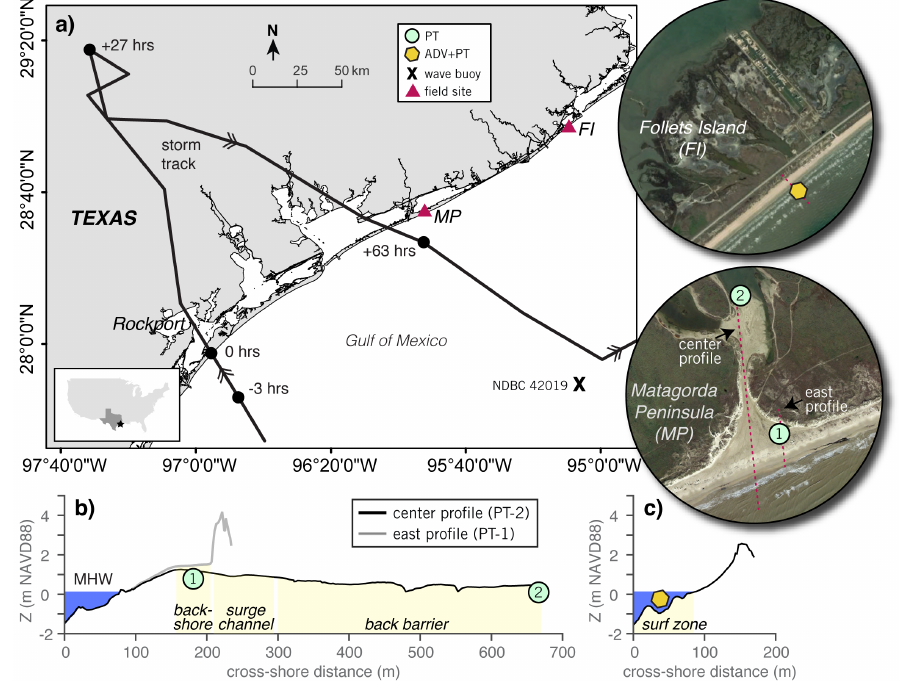
Figure 1. ( a ) location map of both field sites in relation to Hurricane Harvey’s track with relevant storm locations denoted in hours relative to hurricane landfall. ( b ) post-storm cross-island profiles measured proximate to both pressure transducers (PT) at Matagorda Peninsula (“MP”, the east profile bisects PT-1 and the center profile PT-2) and ( c ) the acoustic Doppler velocimeter with co-located PT (ADV+PT) at Follets Island (“FI”). The dotted lines in the aerial subsets of ( a ) delineate the profile locations. Elevation Z is relative to North American Vertical Datum 1988 (NAVD88) and the mean high water (MHW) is plotted for additional